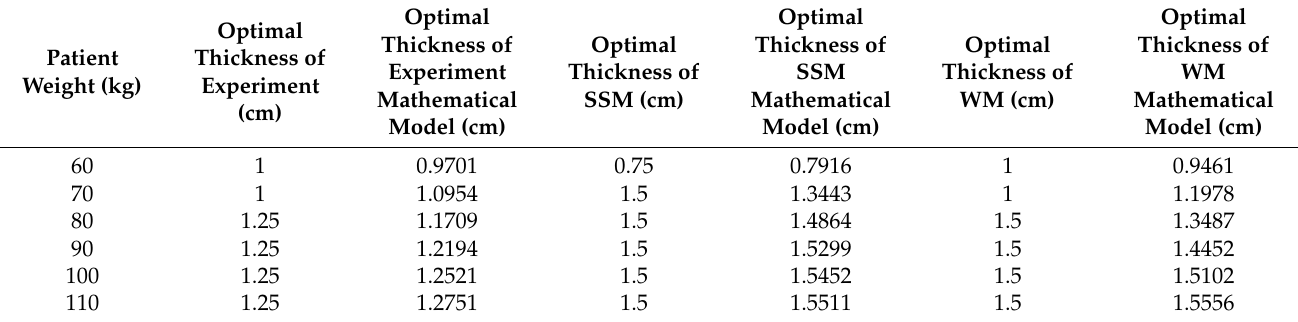
Table 7. Comparison between thicknesses based on mathematical model by power